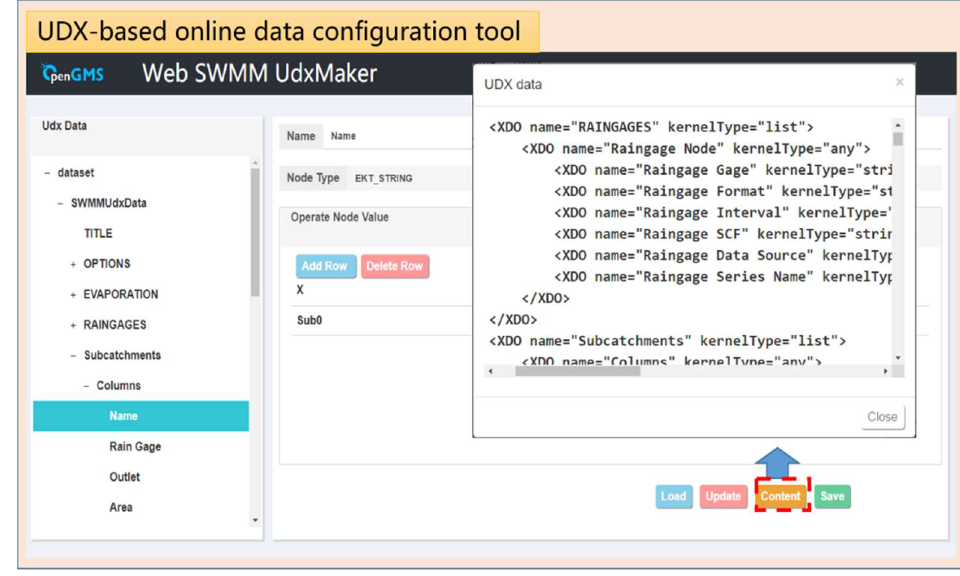
Figure 11. UDX-based online data configuration tool.